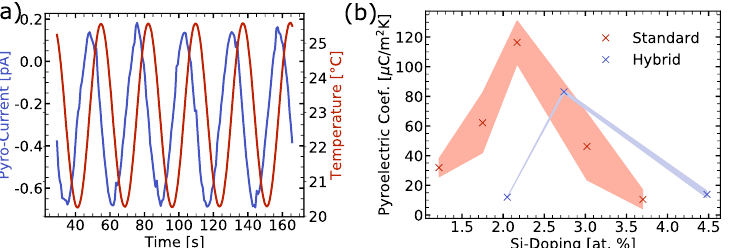
Figure 5. ( a ) Measurements of the pyroelectric current (blue) for set temperatures (red) using the Garn–Sharp method. The offset of between these curves is in theory 90°. ( b ) The pyroelectric coefficient was calculated from the measurements in 5a.